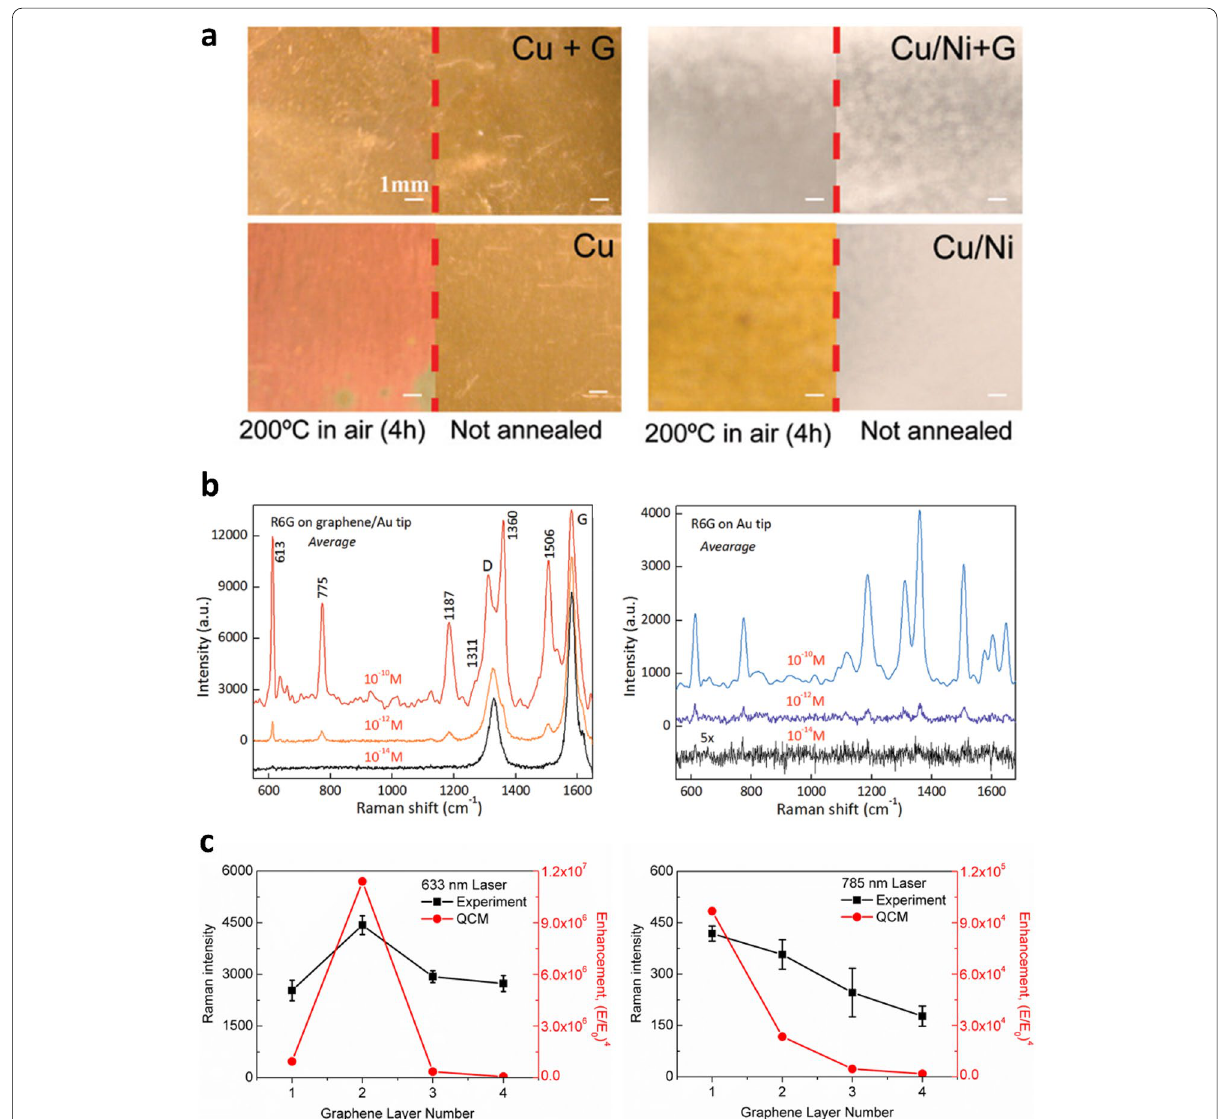
Fig. 5 Roles of graphene in graphene-based plasmonic materials. a Optical images of Cu and Cu/Ni foil with and without graphene coating taken before and after annealing in air (200 °C, 4 h). Reprinted with permission from [84]. Copyright 2011 American Chemical Society. b Raman spectra of R6G on graphene hybrid structure with 3 different concentrations (10 − 10 M, 10 − 12 M, and 10 − 14 M) and Raman spectra of R6G on Au tips with 3 different concentrations. Reproduced with permission from [71] Copyright 2013 WILEY-VCH Verlag GmbH & Co. KGaA, Weinheim. c Graphene as a gap material enabling the thickness control with the sub-nanometer scale precision: comparison between the experimental (black) and computed (red) optical responses for samples excited by a 633 nm laser and a 785 nm laser. The left vertical axis represents the peak Raman intensity measured from a solution of brilliant cresyl blue molecules. The different layer number of graphene gap significantly changes the Raman enhancement of the whole hybrid system. Reprinted under the terms of the Creative Commons License from [94]. Copyright 2019 The Authors. Published by Springer